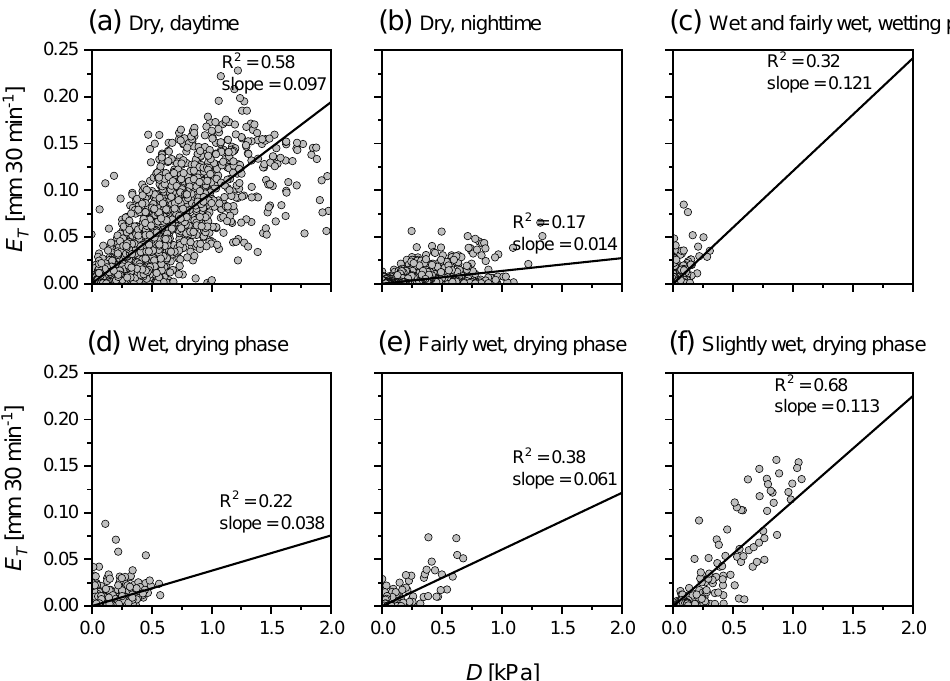
Figure 10. Relationships of half-hourly data between vapor pressure deficit ( D ) and transpiration ( E T ) at the Juvenile site under different canopy conditions: ( a ) dry during daytime ( R n > 10 W m − 2 ), ( b ) dry during nighttime ( R n < 10 W m − 2 ), ( c ) wet and fairly wet during wetting phases, ( d ) wet during drying phase, ( e ) fairly wet canopy during drying phase, and ( f ) slightly wet during drying phase.